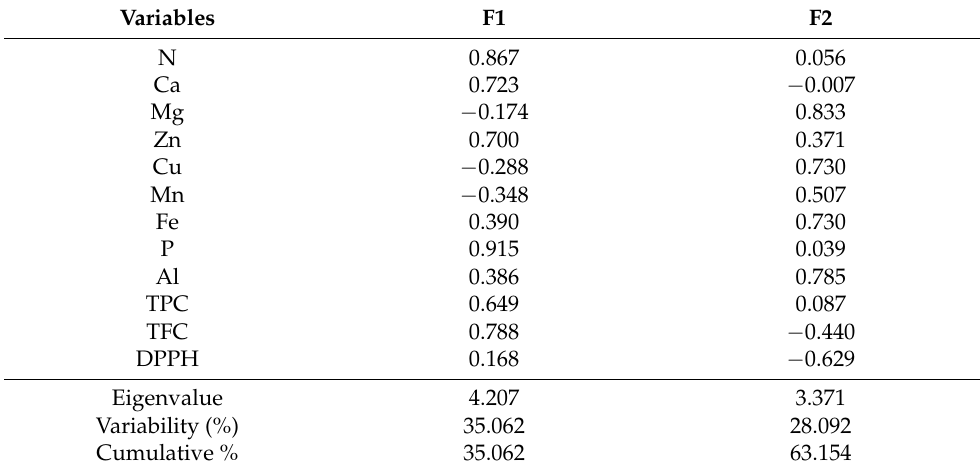
Table 7. The principal component (PC) factor loadings and eigenvalues for mineral content, total polyphenol, and antioxidant